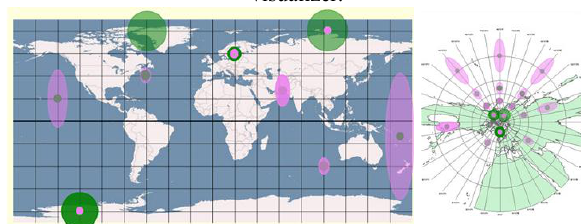
Figure 7. Examples ellipses in the map section of the visualizer.